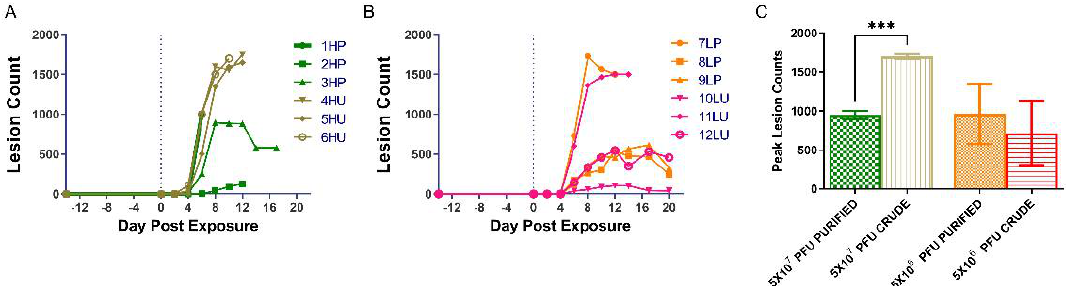
Figure 3. Temporal and total lesion counts for nonhuman primates exposed to either purified or unpurified preparations of monkeypox virus. Lesions were quantified and categorized every 2nd day post exposure in one of four groups: Macular/papular/vesicular, pustular/umbilicated, scabbing, and desquamating. The individual lesion counts per day for the high dose groups and the low dose groups and presented in ( A , B ), respectfully. The maximum number of lesions for each animal were combined per the individual’s respective group ( C ). A two-tailed t -test was performed between the two high dose groups and between the two lower dosed groups. A statistical difference was noted when comparing the maximum lesion counts in the high dose groups ( p = 0.0008) and is represented by the asterisk. HP, high dose purified; LP, low dose purified; HU, high dose crude; LU, low dose crude.